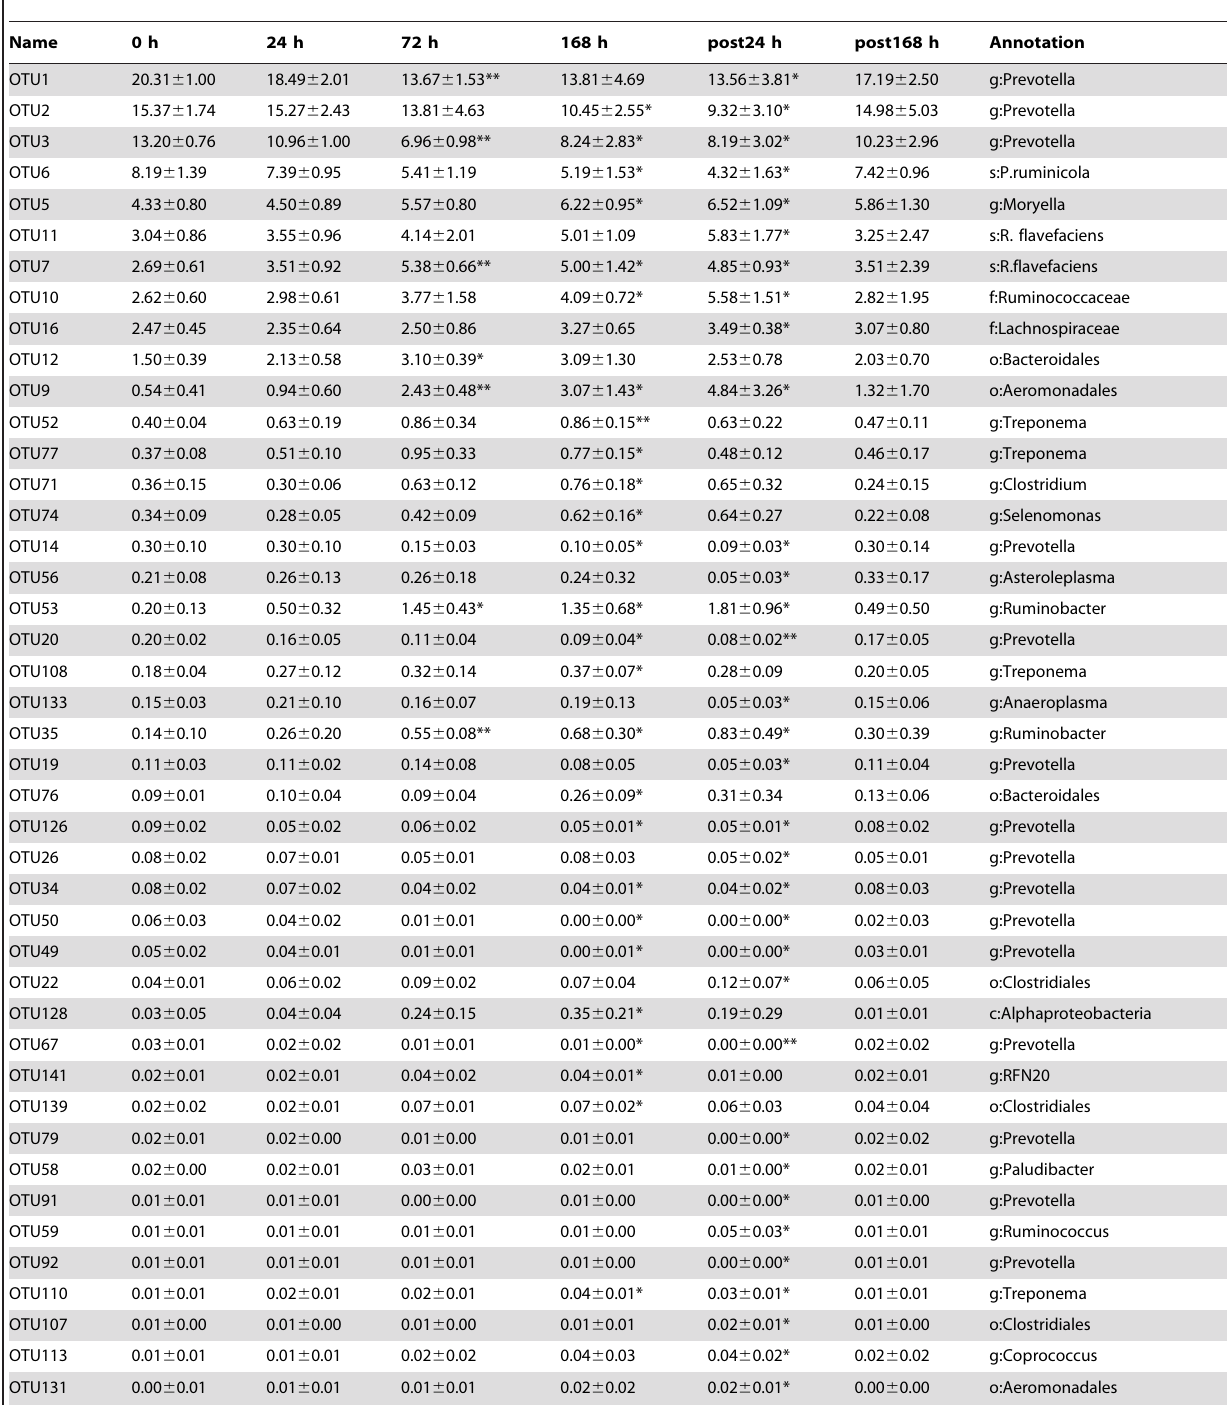
Table 3. Ruminal butyrate infusion resulted in a profound change in the species-level rumen microbial composition (mean percentage 6 SD; N